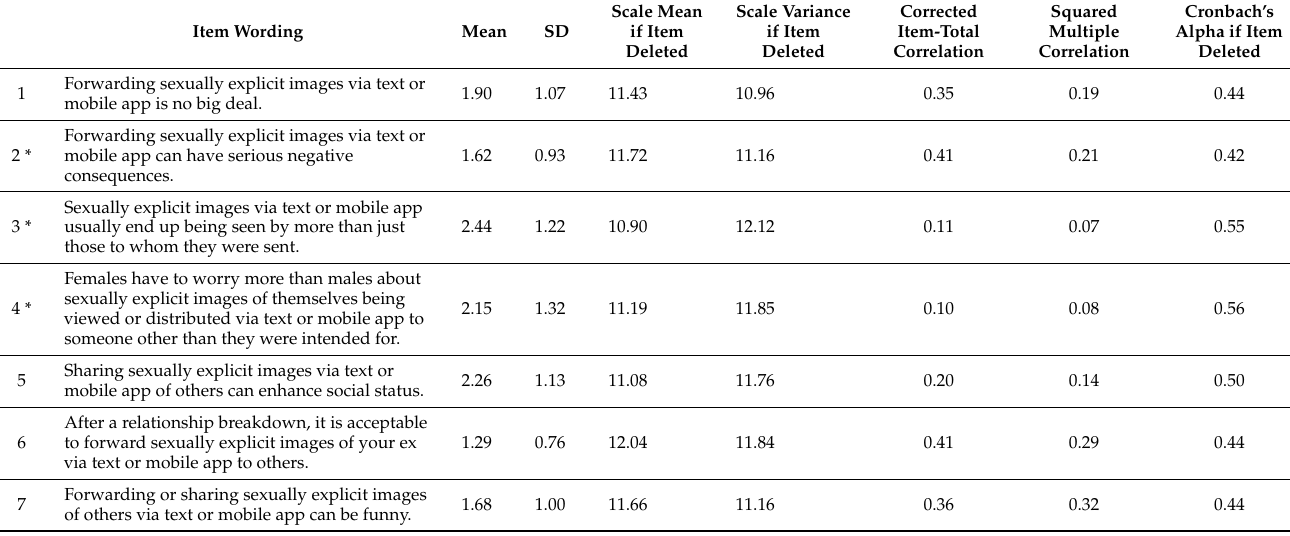
Table A1. Item and scale totals and correlations for Subjective Norms and Attitudes to Sext Dissemination Scale (SNA). Item Wording Mean SD